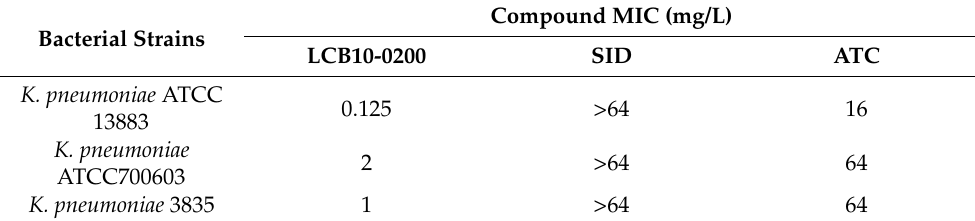
Table 1. Comparative in vitro activities of LCB01-0200, SID, and ATC against Klebsiella pneumoniae . Bacterial Strains